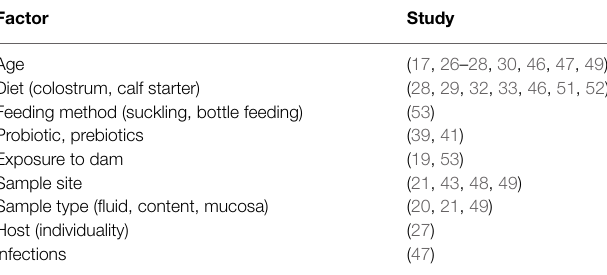
TABLE 1 | Factors influencing pre-weaned calf rumen/gut microbiota . Factor